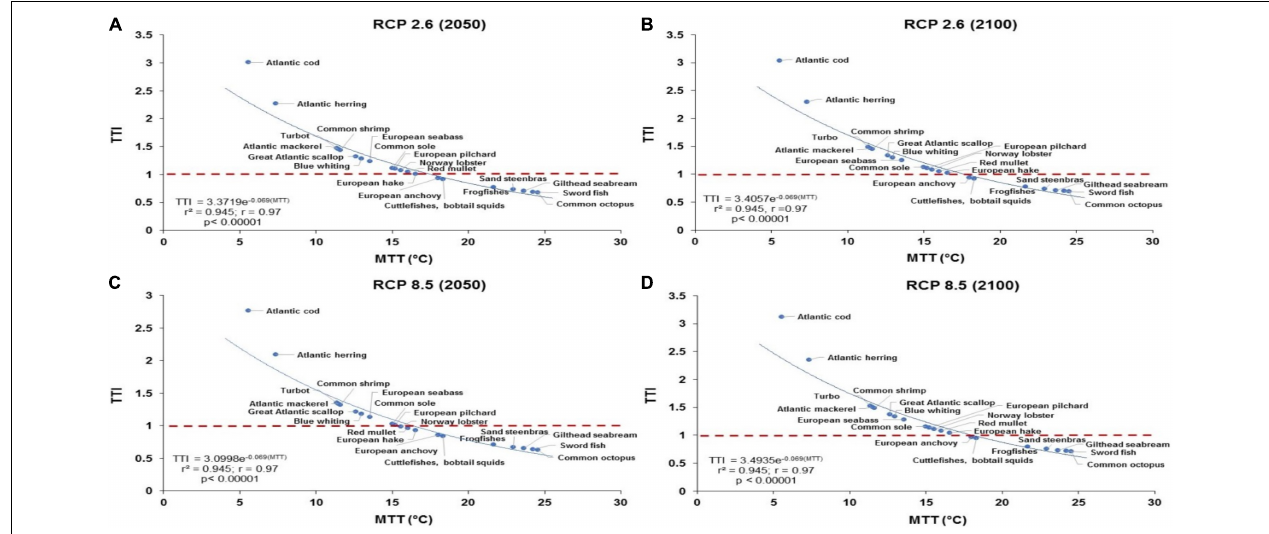
FIGURE 4 | The relationship between the estimated TTI (TTI = SST CC /MTT) for all fish species assessed vs. the species-specific MTT under RCP 2.6 (i.e., low CO 2 emission/high mitigation scenario) for (A) 2050 and (B) 2100; and RCP 8.5 (high CO 2 emissions or business-as-usual) for (C) 2050 and (D) 2100. The relationship between TTI and MTT under RCP 8.5 shows that most temperate pelagic and benthopelagic species will be affected either by high SST under RCP 8.5 and even under the mitigation scenario (RCP 2.6), as an indication of high sensitivity of exposure to ocean